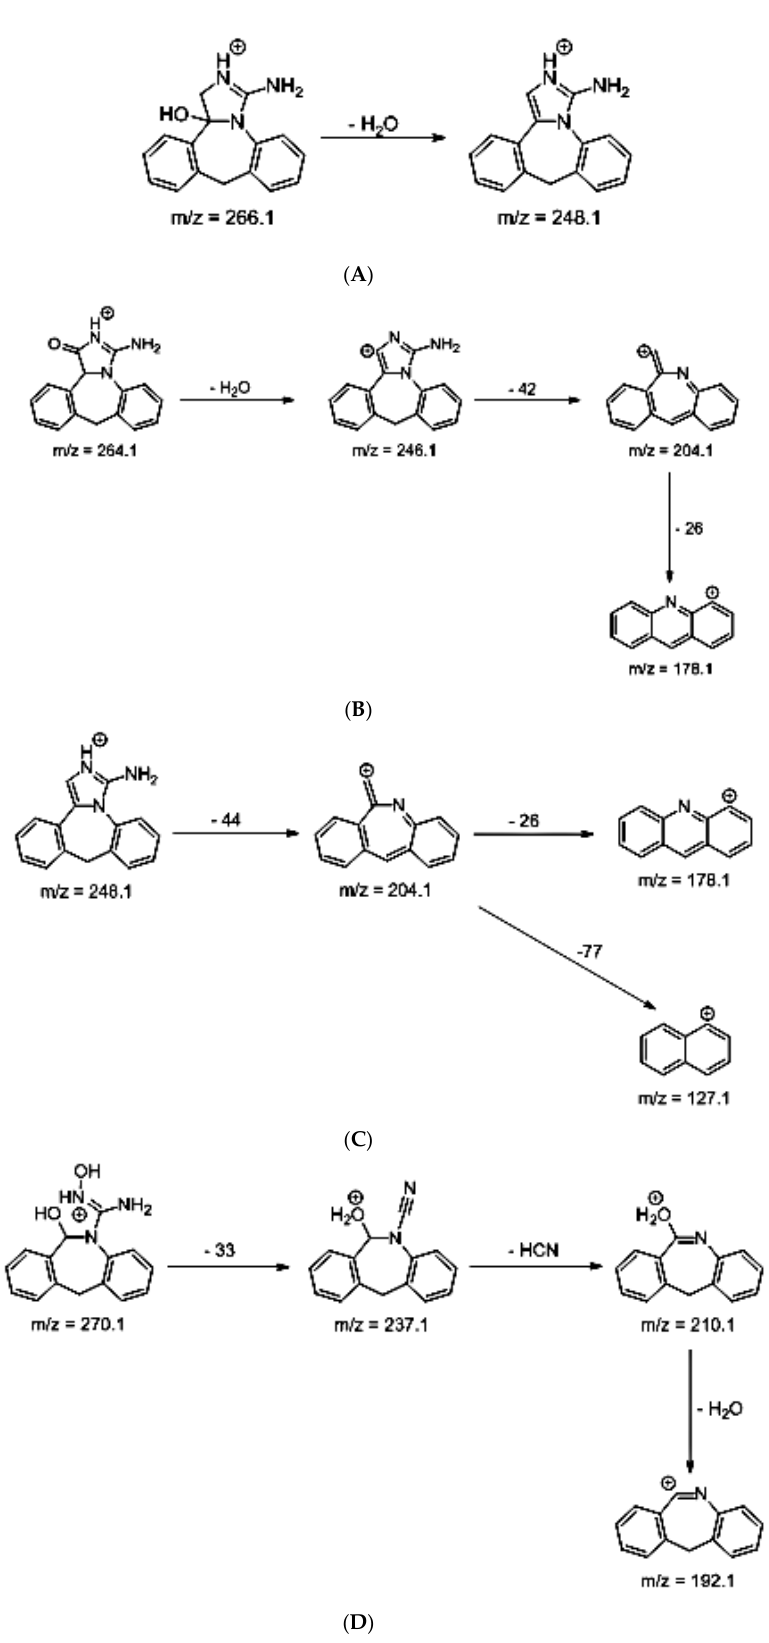
Figure 8. Proposed fragmentation patterns of EPI-P1 ( A ), EPI-P2 ( B ), EPI-P3 ( C ), and EPI-P4 ( D ).